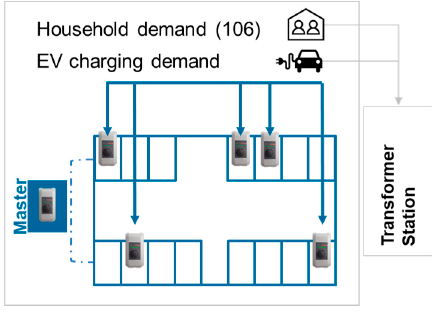
Figure 3. Private charging network: The master station controls all sub-stations.